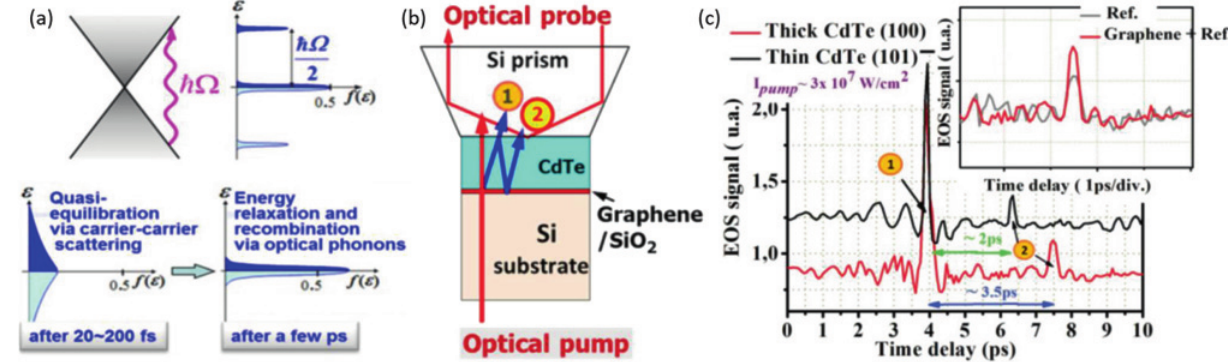
Figure 8: THz interband amplification in graphene. (a) Time evolution of the graphene electronic distribution function f ( ε ) after photoexcitation with light of photon energy - Ω . If intraband equilibration is suf fi ciently faster than interband recombination, a population inversion can be established. (b) Experimental sample geometry used to investigate THz ampli fi cation in optically pumped graphene. (c) Measurement results based on the geometry of (b). The black and red traces show the THz signals measured by electro-optic sampling (EOS) for two different thicknesses of the CdTe crystal, as a function of delay time between the optical pump and probe. The inset shows the THz signal peaks measured after a round-trip inside the crystal [path ② of (b)] with (red) and without (gray) a graphene sheet under the CdTe crystal. The larger peak value of the red trace is an indication of THz ampli fi cation by the photoexcited graphene carriers. Reprinted with permission from ref. [109]. Copyright (2012) by the American Physical